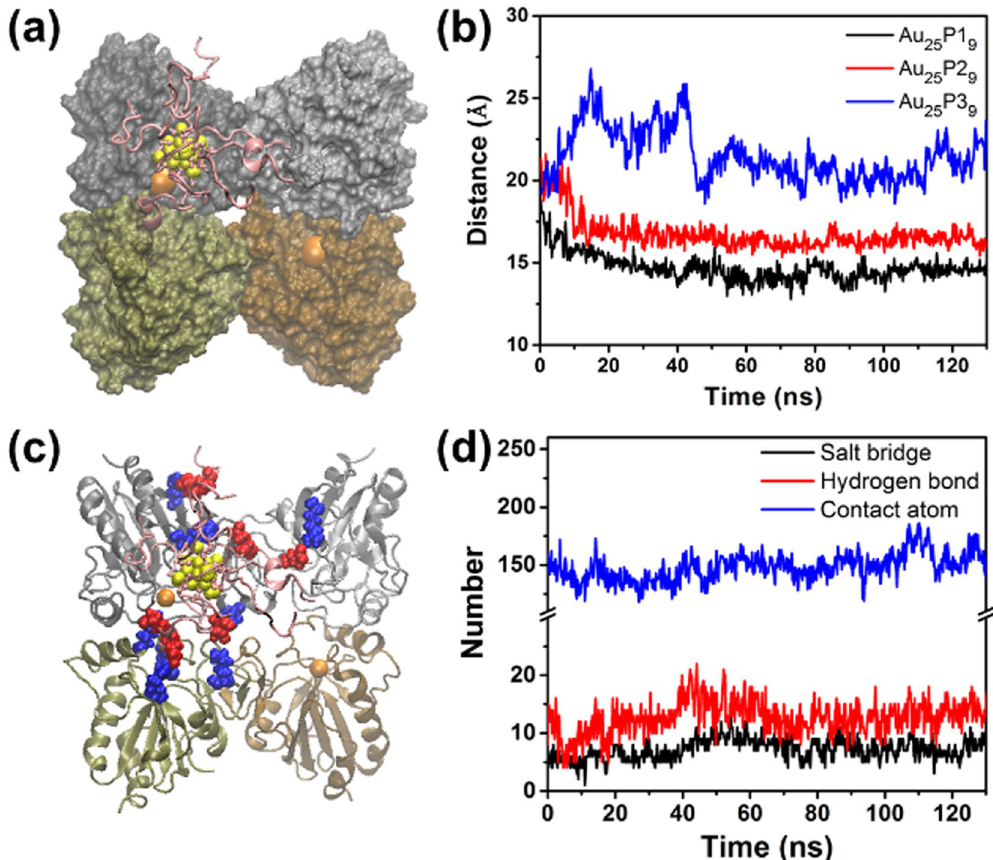
Figure 1. Comparison of GPx-1 binding abilities of Au 25 P1 9 , Au 25 P2 9 and Au 25 P3 9 candidates. ( a ) The stable configuration of designed Au 25 P1 9 bound to the active site in subunit A of GPx-1 (at the 126 th ns in MD simulation). ( b ) Distance between the Se atom of Sec45 (active site in subunit A) and the Au 25 core COM of Au 25 P1 9 (black), Au 25 P2 9 (red) and Au 25 P3 9 (blue) during their binding dynamics to GPx-1. ( c ) Salt bridge distribution between designed Au 25 P1 9 and GPx-1 surface in the stable configuration (at the 126 th ns in MD simulation). Positive and negative charged residues are in blue and red, respectively. ( d ) The number of salt bridges (black), hydrogen bonds (red) and contact atoms (blue) between designed Au 25 P1 9 and GPx-1